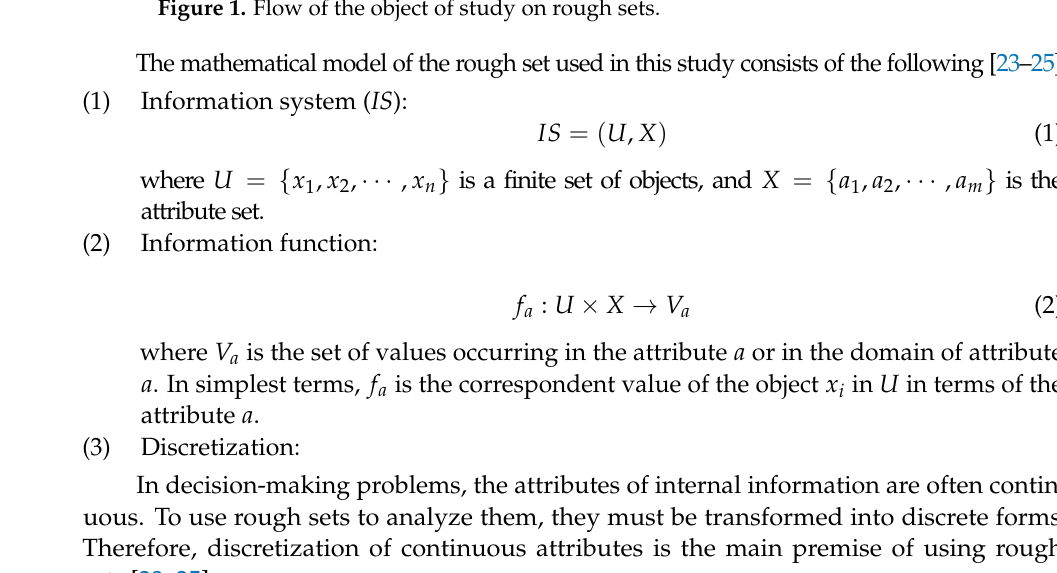
Figure 1. Flow of the object of study on rough sets.